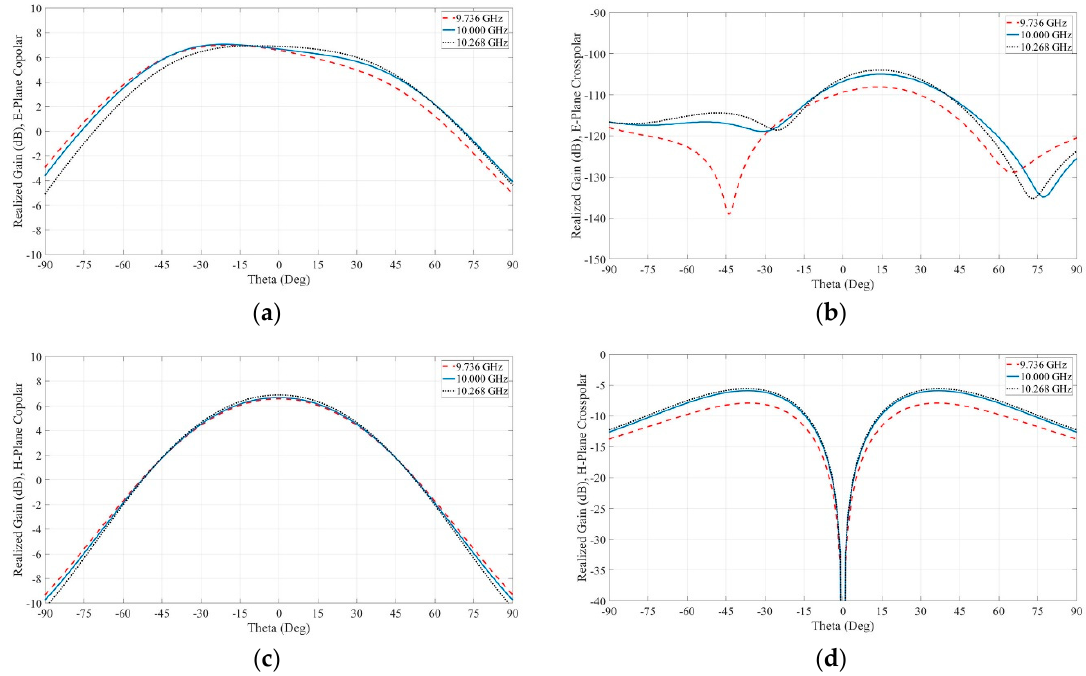
Figure 9. MPA3 radiation pattern: ( a ) E-plane copular, ( b ) E-plane crosspolar, ( c ) H-plane copular, ( d ) H-plane crosspolar. The broadside gain versus frequency is depicted in Figure 10 for all radiating elements.